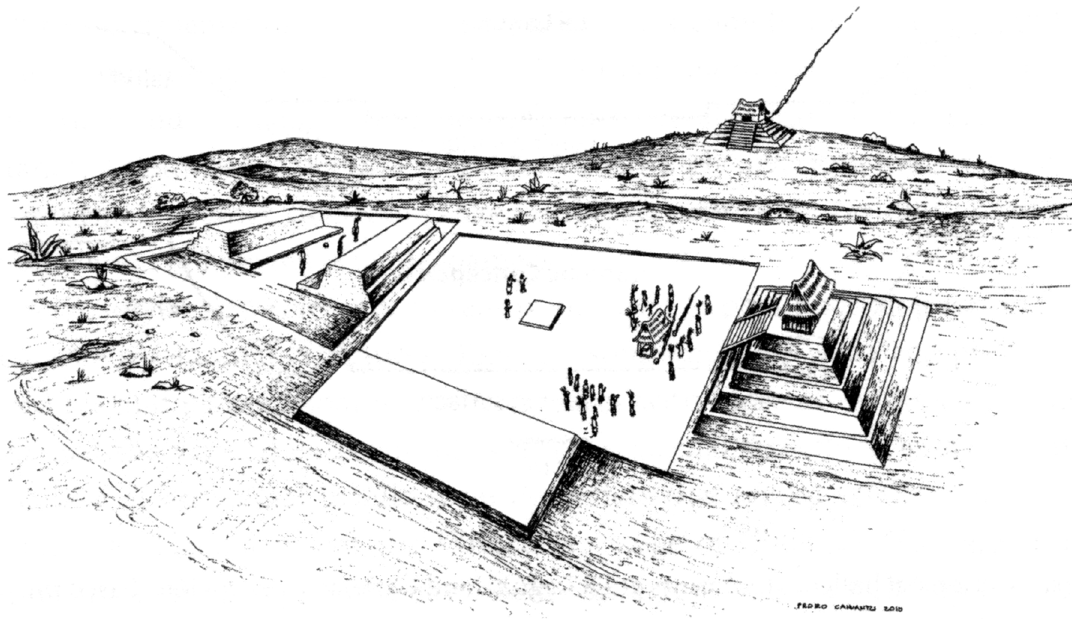
Figure 3. Reconstruction drawing of La Laguna. Reproduced with permission from Carballo